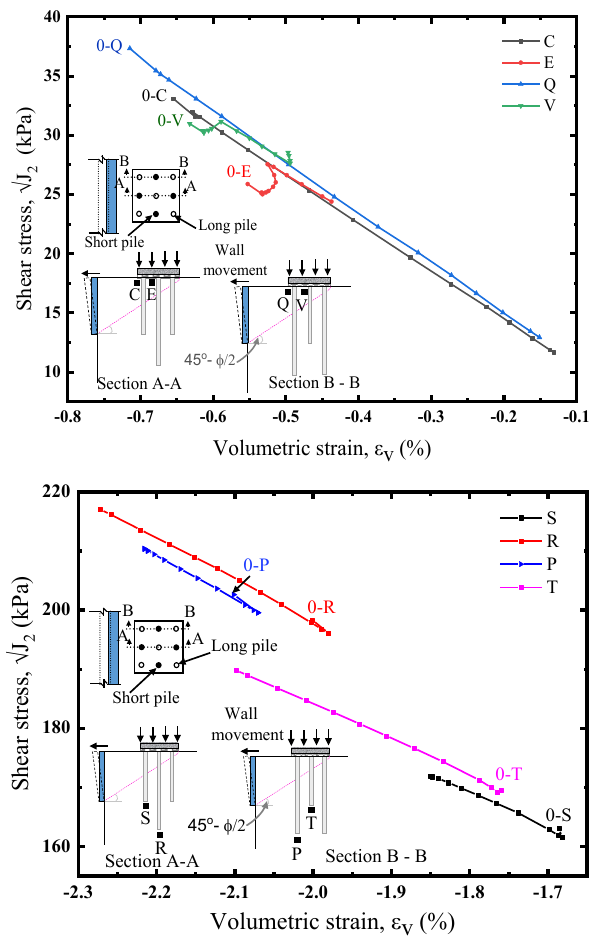
Figure 14: Computed shear stress–volumetric strain curves for monitoring points (a) in the upper soil near pile shaft and (b) underneath pile